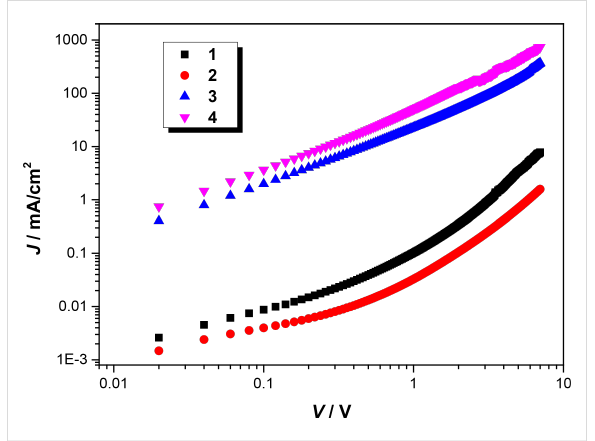
Figure 5: J – V curves of COOP- n HT-TBDT:PC 61 BM-based hole-only devices.